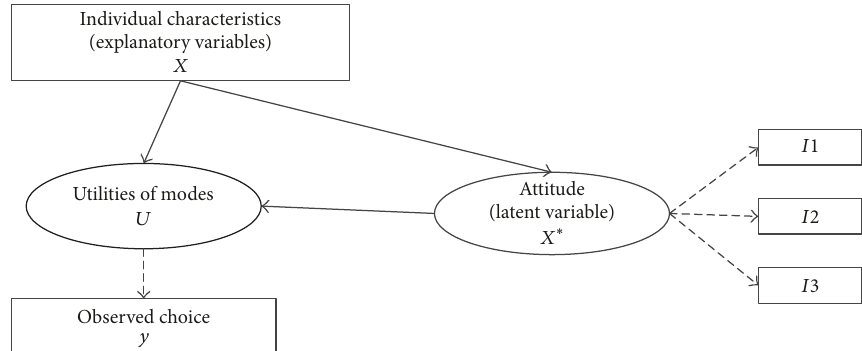
Figure 2: Modeling